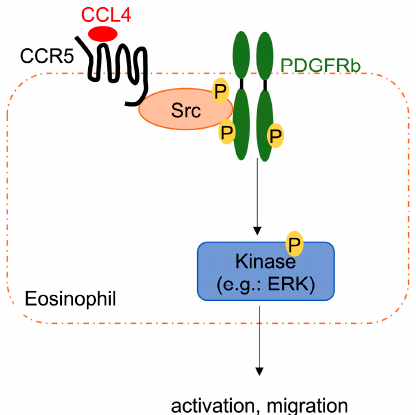
Figure 5. Mechanism of CCL4-mediated transactivation in the eosinophil signaling pathway. CCR5—a transmembrane protein coupled to G proteins that is stimulated with CCL4—induces PDGFR β transactivation via tyrosine phosphorylation of Src, which leads to biological activities in